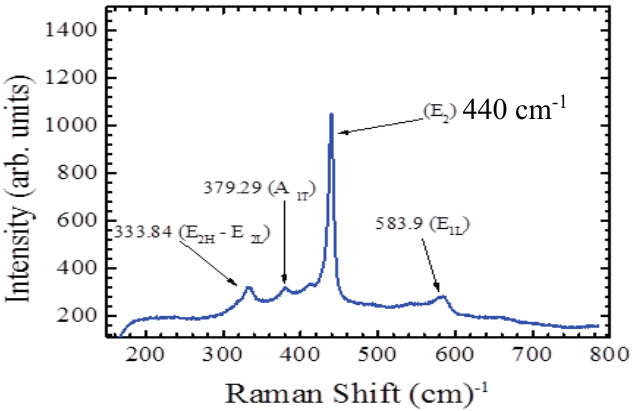
Figure 3. Raman spectrum of the grown ZnO nanorods and the observed peaks that correspond to the phonon vibration at room temperature.